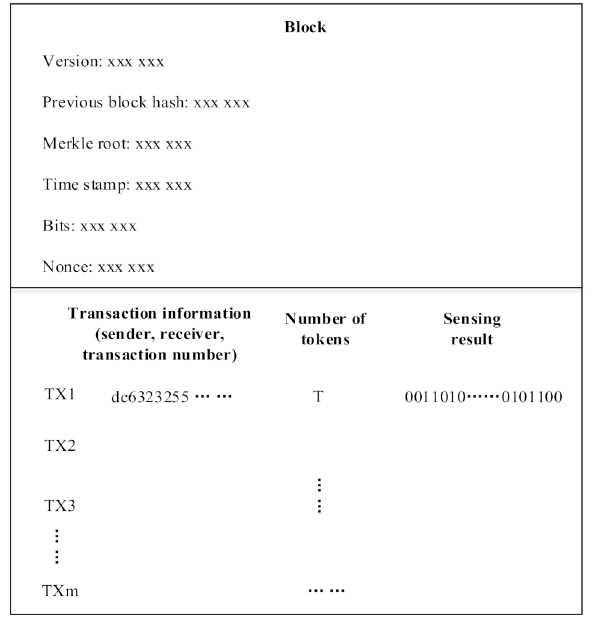
Figure 6. Block of transaction uploaded by node sensing